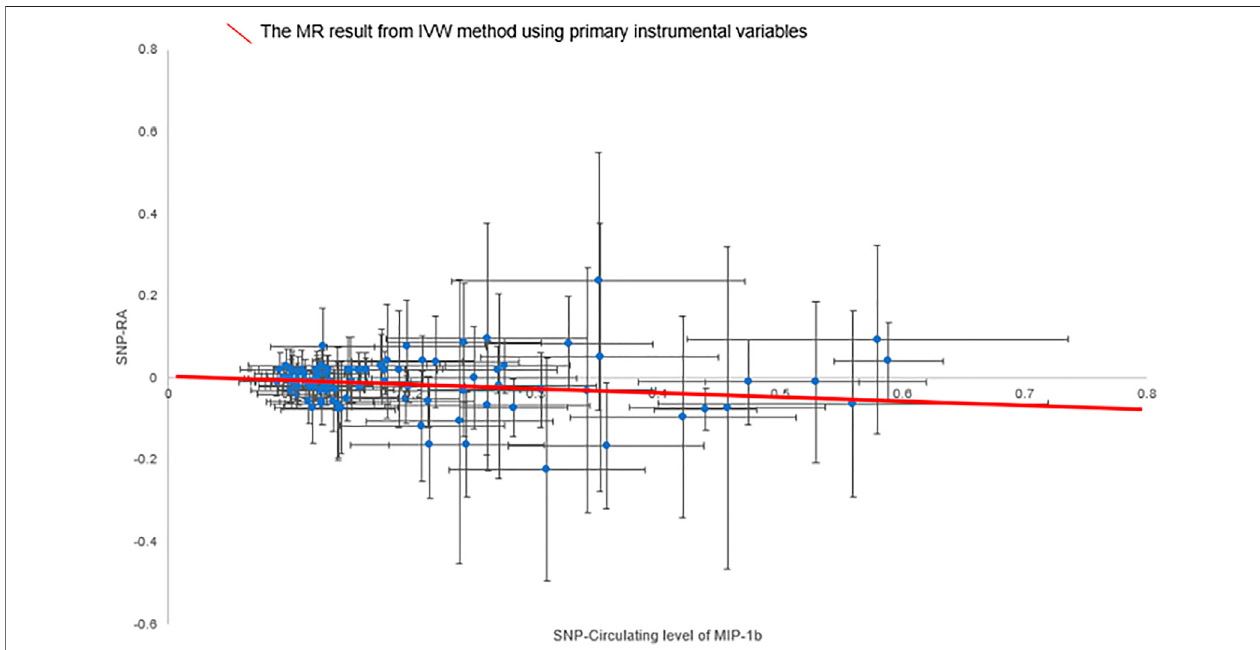
FIGURE 3 | Scatter plot of the associations of genetic variants with circulating level of MIP-1b and the risk of rheumatoid arthritis. Abbreviations: IVW, inverse- variance weighted; MIP-1b, macrophage in fl ammatory protein-1 β ; MR, Mendelian randomization; SNP, single nucleotide polymorphism; RA, rheumatoid arthritis.